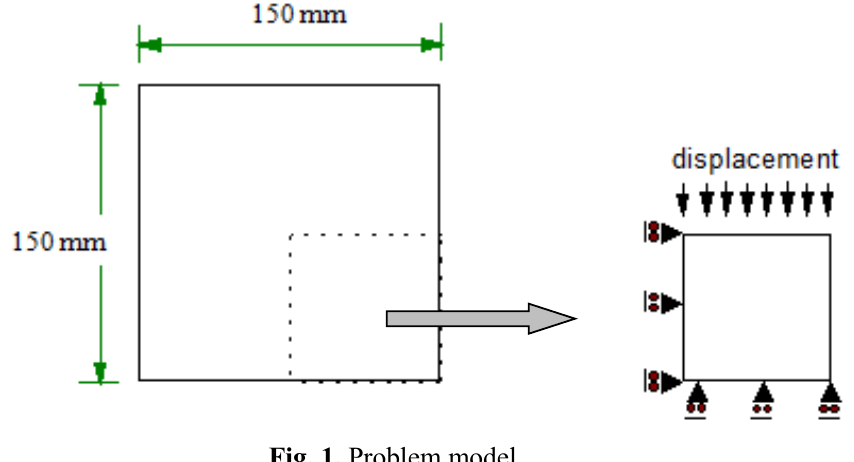
Fig. 1. Problem model.